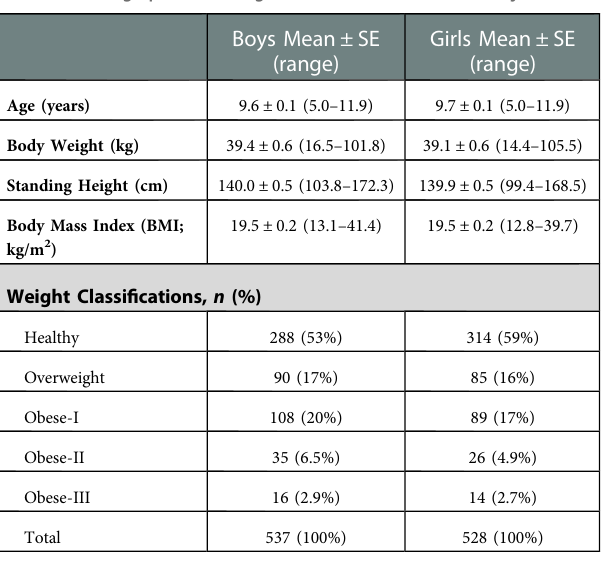
TABLE 1 Demographic and weight classi fi cation distribution by